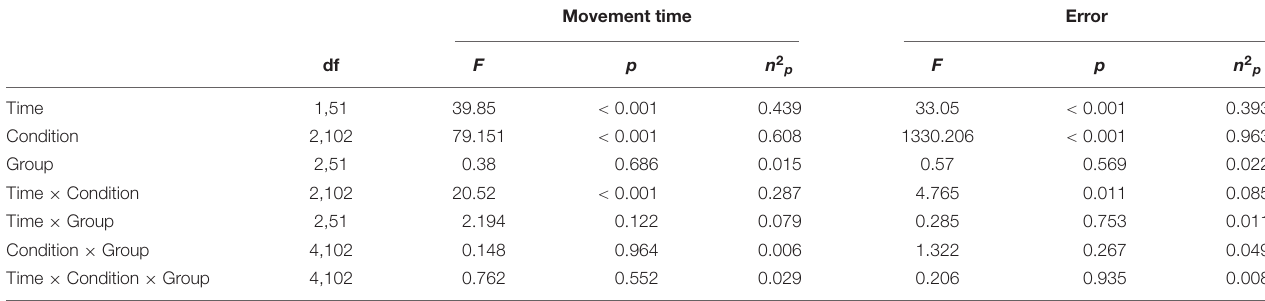
TABLE 2 | Results of the 2 × 3 × 3 ANOVA.